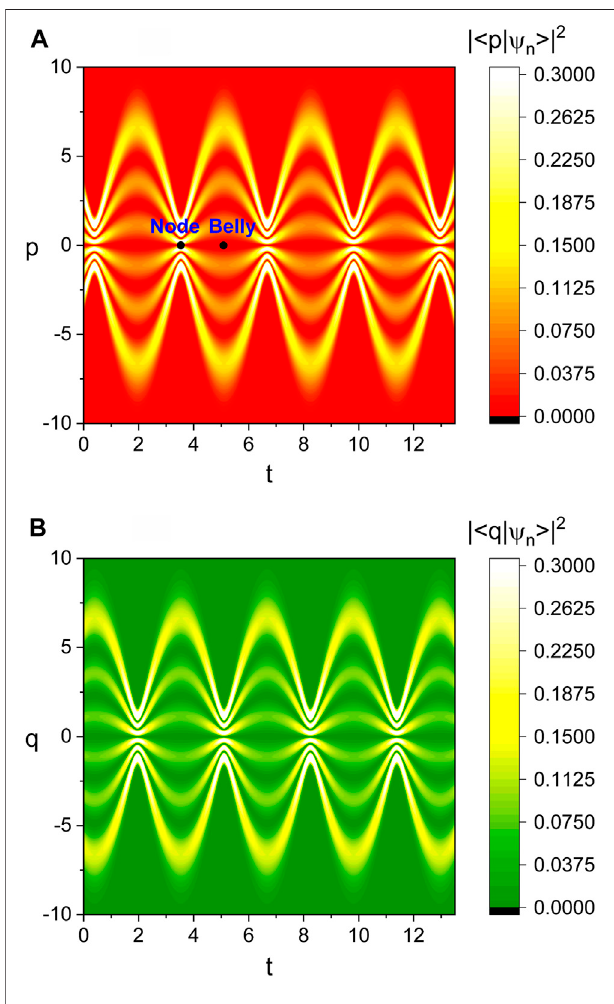
FIGURE 1 | (A) is the density plot of the probability density in p -space, | 〈 p | ψ n ( t ) 〉 | 2 , as a function of p and t . For comparison purposes, we have also representedtheprobabilitydensityin q -space,| 〈 q | ψ n ( t ) 〉 | 2 ,in (B) asafunctionof q and t .Thevaluesthatweusedare A (cid:1) 1, B (cid:1) 5, C (cid:1) 2, ω (cid:1) 1, n (cid:1) 5, Z (cid:1) 1, ϵ (cid:1) 1, t (cid:1) 0,and φ (cid:1) 0.Allvaluesaretakentobedimensionlessforconvenience; 0 this convention will also be used in all subsequent fi